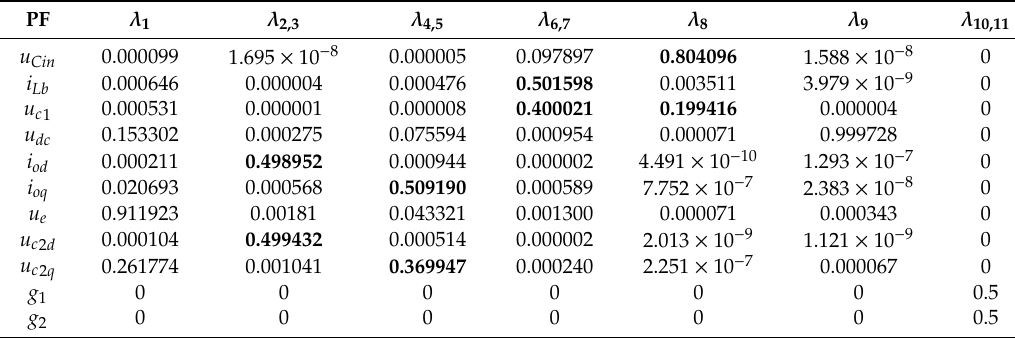
1 The bold sections represent the main key data.